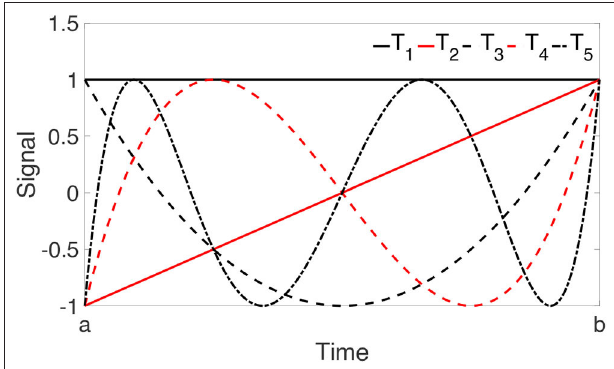
FIGURE 3 | First five adjusted Chebyshev polynomials for a general range of [a, b].